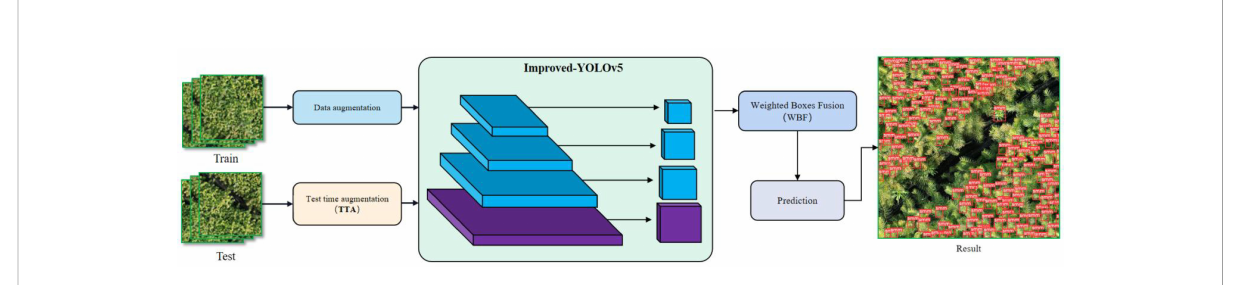
FIGURE 11 Improved YOLOv5 work fl ow chart.